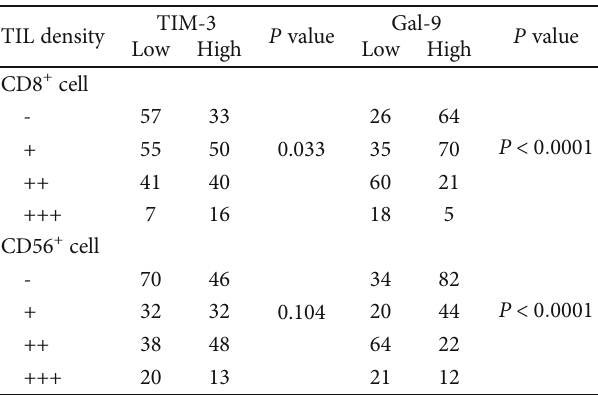
Note: Spearman ’ s correlation coe ffi cients were calculated with two-sided models. Table 4: Association of TIM-3, Gal-9 levels with CD8 + and CD56 + TIL densities in